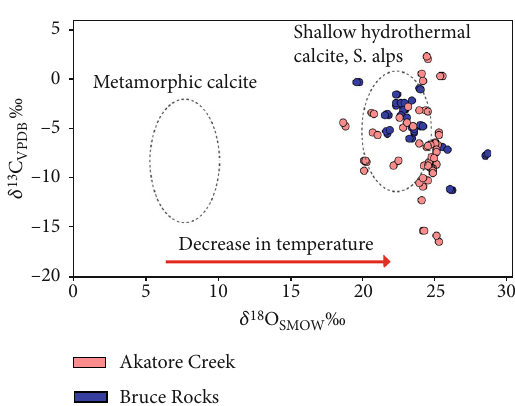
‰ and δ 18 O ‰ of carbonates from Figure 9: δ 13 C VPDB SMOW Akatore Creek and Bruce Rocks, compared with the fi elds for primary metamorphic calcite and shallow hydrothermal calcite in the Southern Alps of New Zealand [10]. Remobilisation and recrystallisation of metamorphic calcite and precipitation at a lower temperature are interpreted to have caused an increase in δ 18 O ‰ (indicated by SMOW around 143 Nd/ 144 Nd = 0 : 5126 (Figure 8(a)), with the excep- tion of one fault breccia sample that is less radiogenic (sample 8: 143 Nd/ 144 Nd = 0 : 51249 ; Figure 8(a), Table 3).